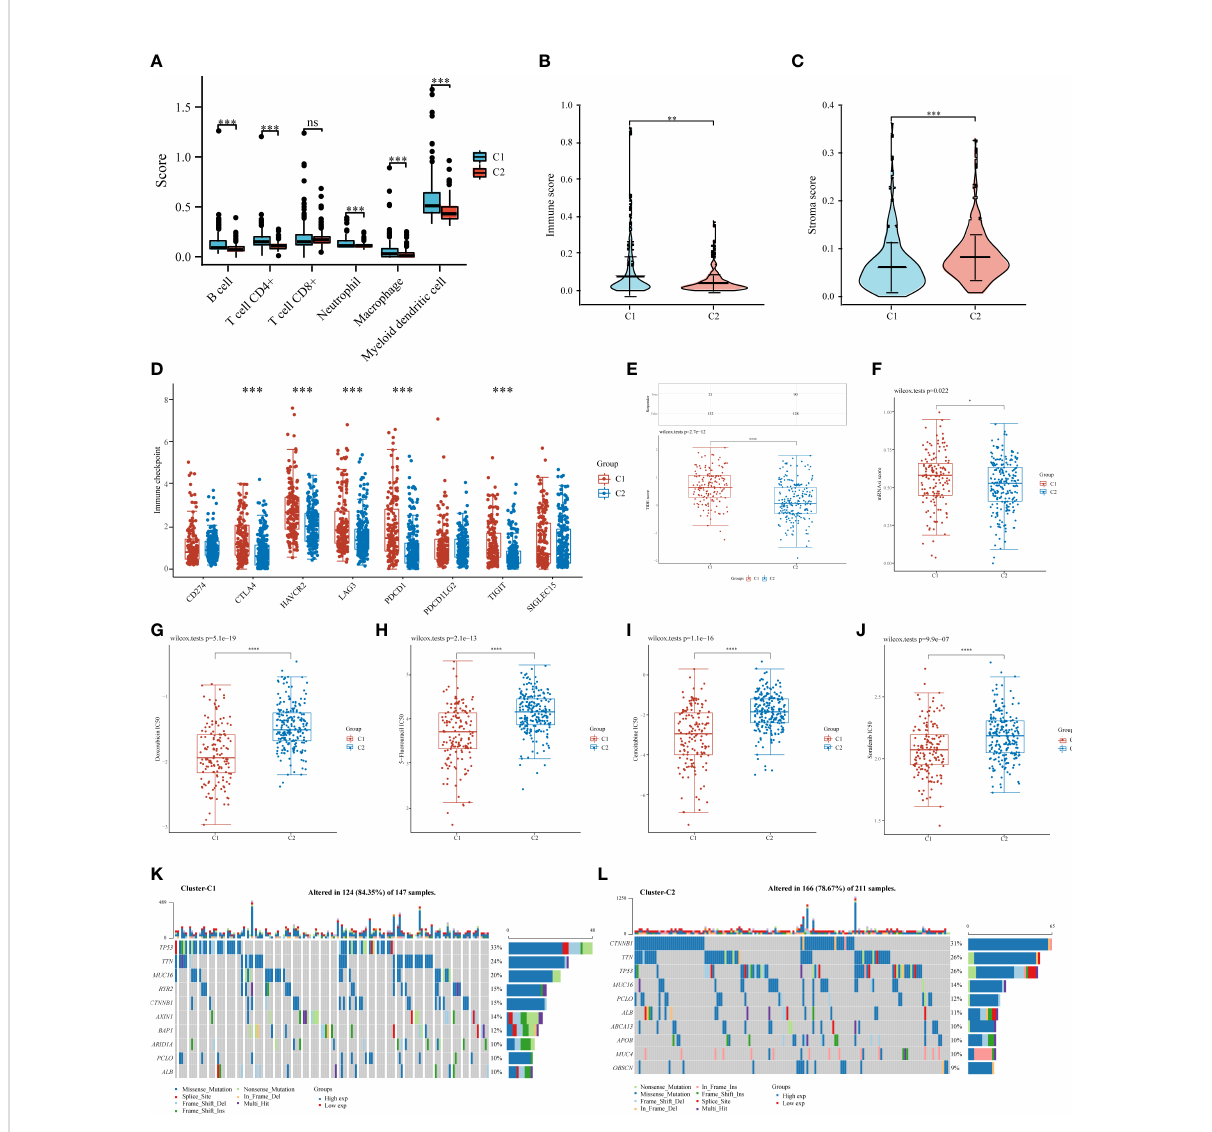
FIGURE 6 Comparisons of immune status, stemness, ICB response, and chemotherapy response between C1 and C2. Box plots present differential immune in fi ltration (A) , immune score (B) , stroma score (C) , immune checkpoint gene expression (D) , TIDE score (E) , mRNAsi score (F) , doxorubicin IC50 (G) , 5- fl uorouracil IC50 (H) , gemcitabine IC50 (I) , and sorafenib IC50 (J) . Oncoprint visualization of the top 10 most commonly mutated genes in C1 (K) and C2 (L) . mRNAsi, mRNA expression-based stemness index. (*P < 0.05; **P < 0.01; ***P < 0.001; ****P < 0.0001; ns, not signi fi